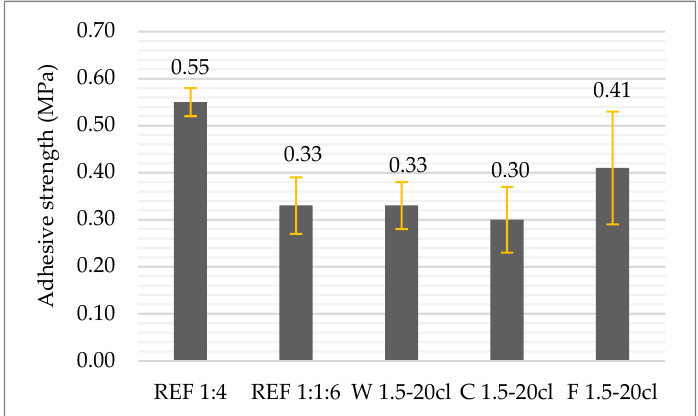
Figure 12. Adherence strength of the mortars at 28 days.